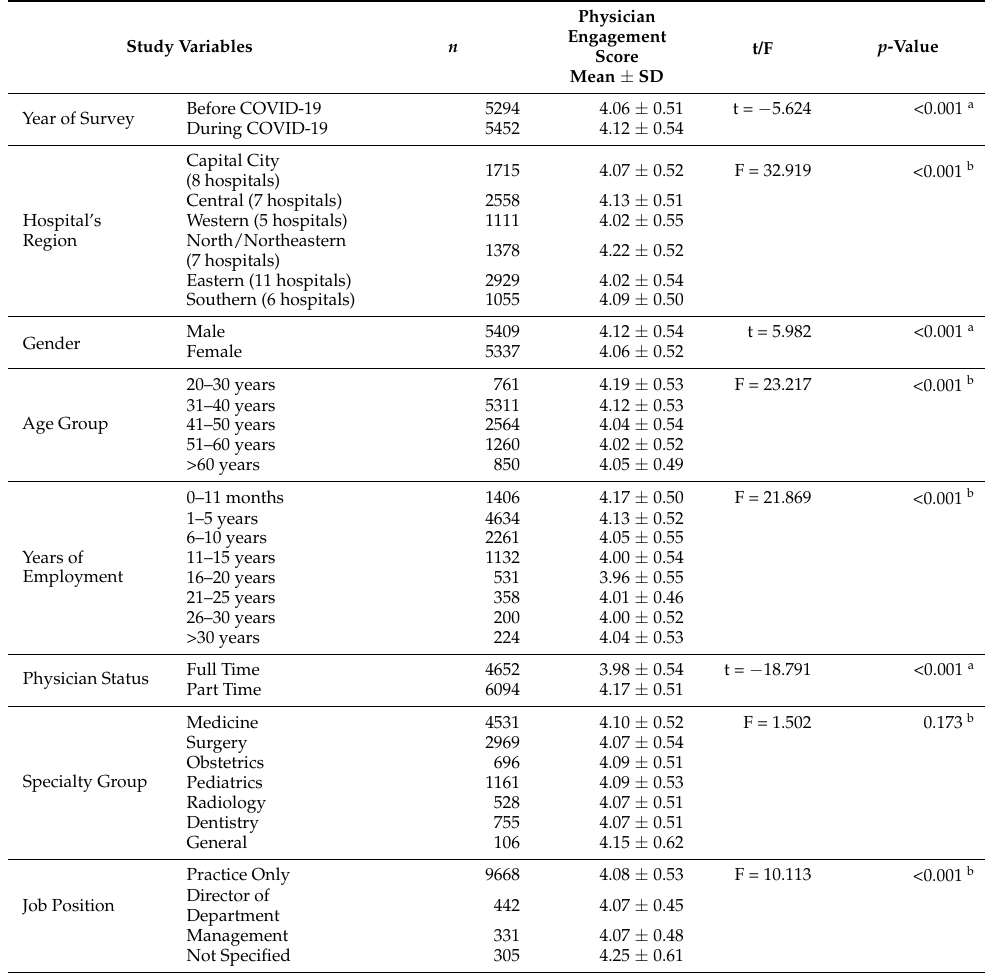
Table 2. The study variables and physician engagement